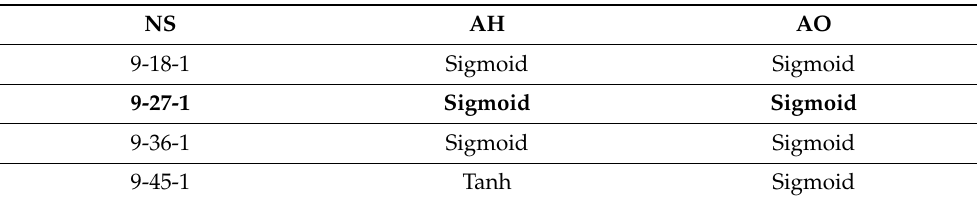
Table 1. The best MLP (MultiLayer Perceptron) network models for diagnostic measures (bolded is the best, see also Tables 2 and 3 for more results).